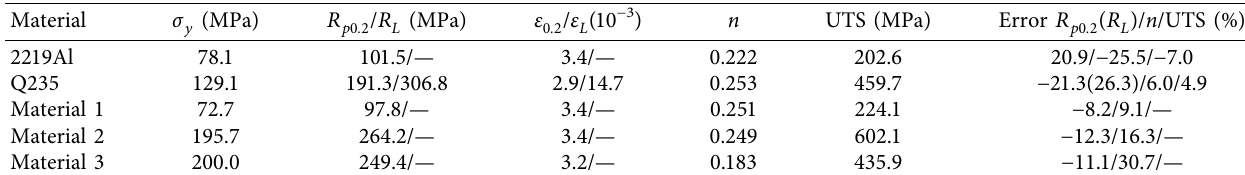
Table 5: Plastic properties obtained from Ogasawara’s method.